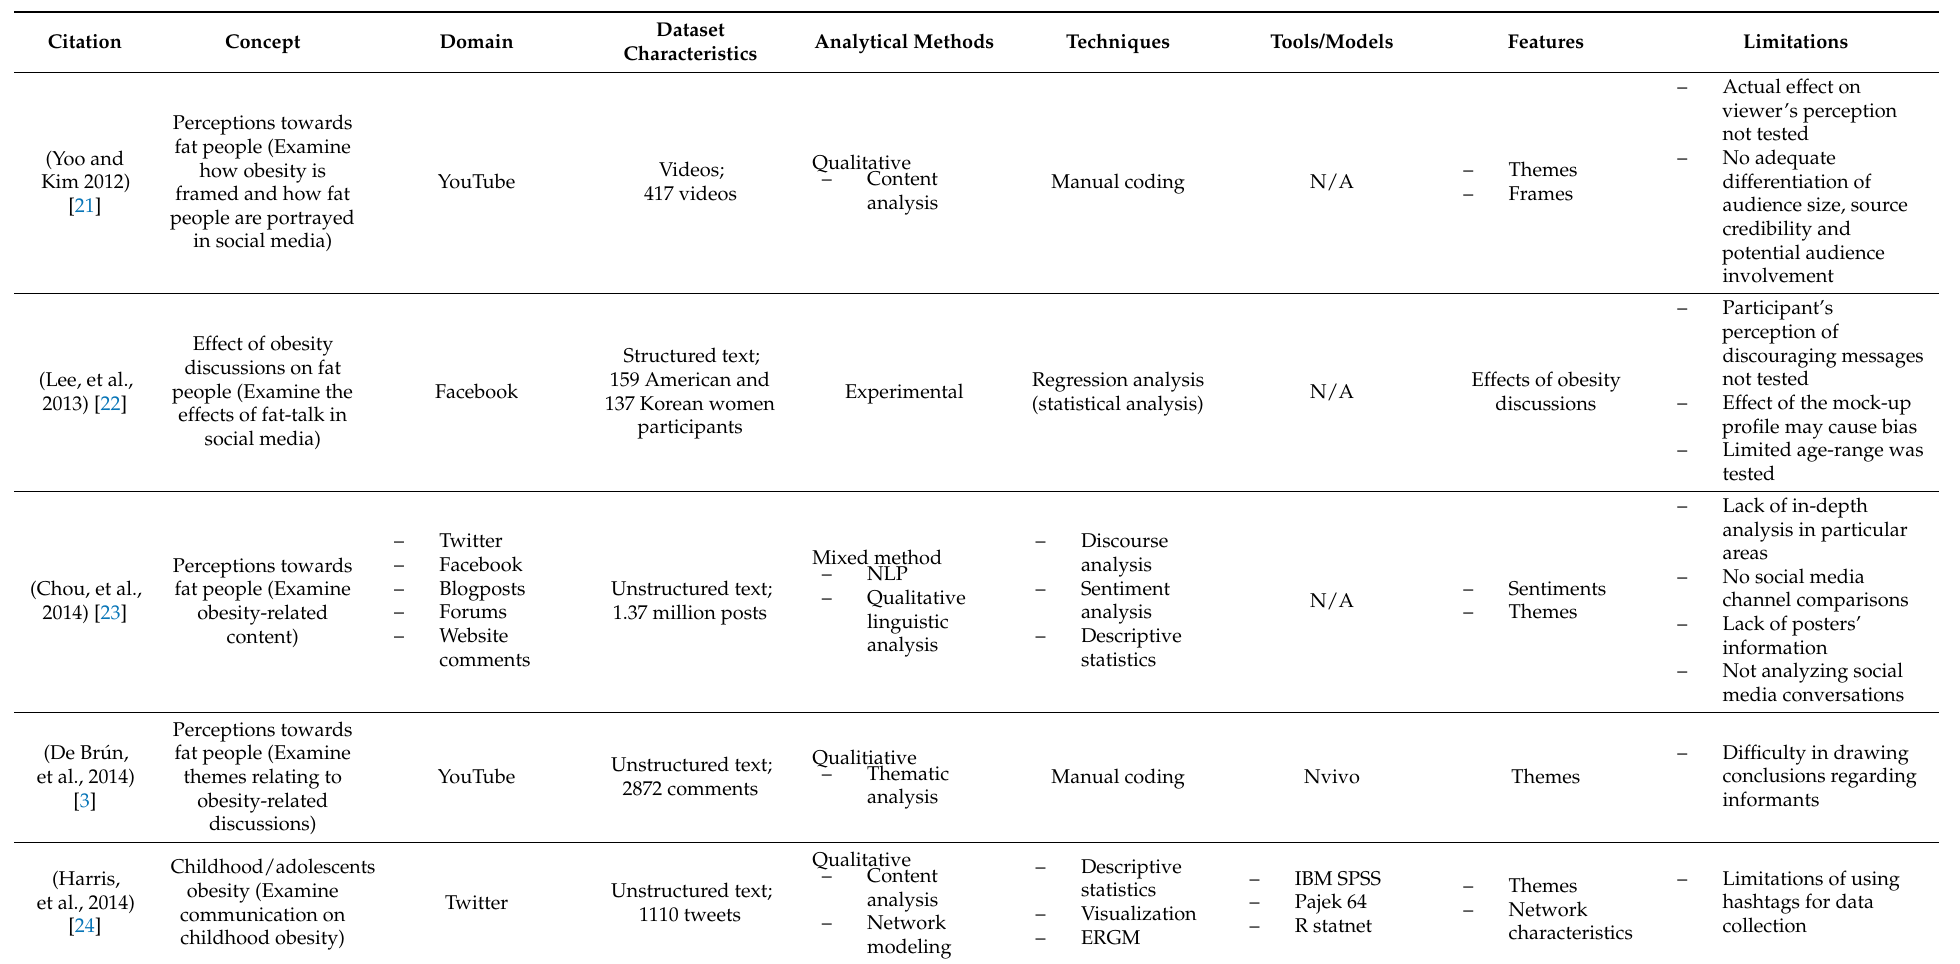
Table 2. Literature on fat stigma in social